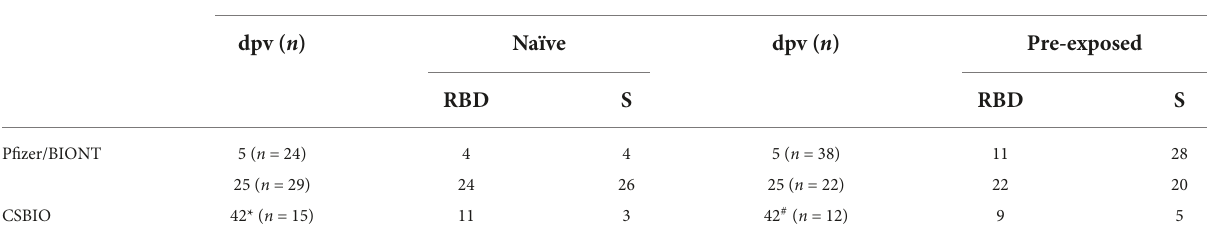
TABLE 3 Number of individuals with and without previous exposure to SARS-CoV-2 showing IgG reactivity against the SARS-CoV-2 antigens RBD and S in serum collected from Pf-BNT and CSBIO vaccine recipients. Vaccine IgG positivity ( n